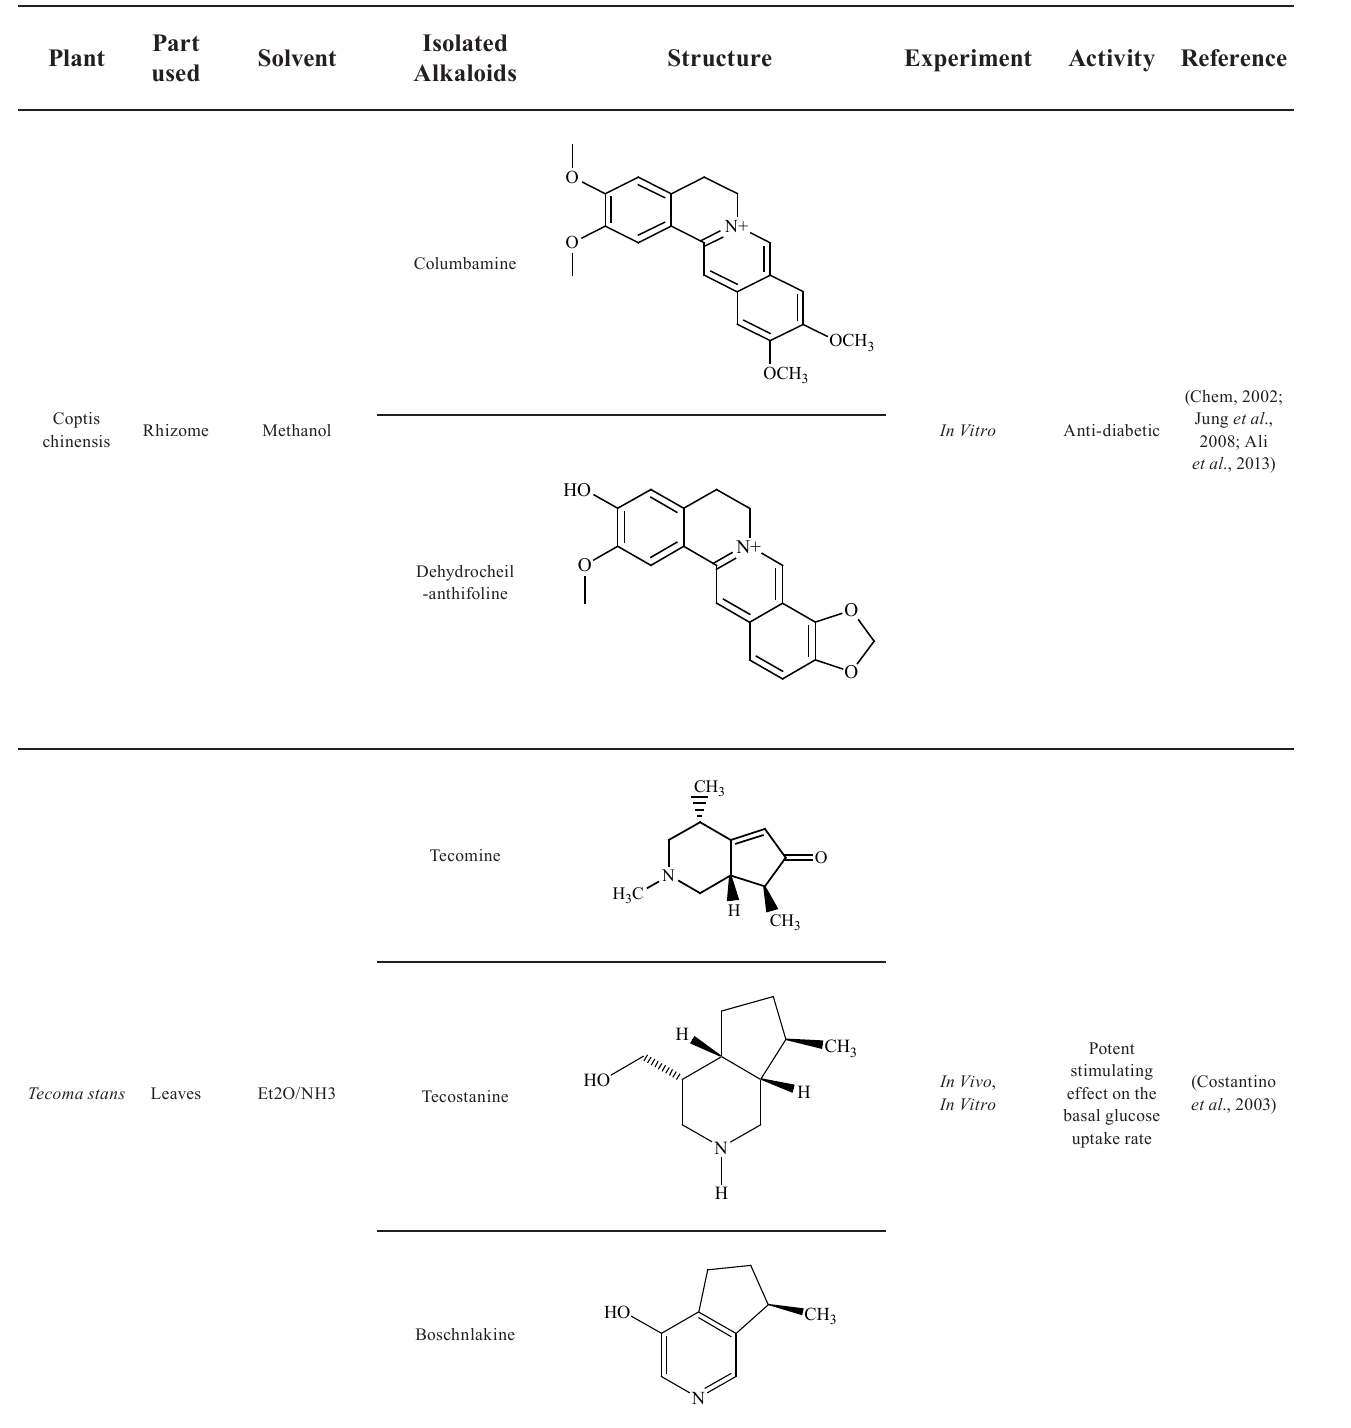
TABLE I – A lkaloids with anti-diabetic activity